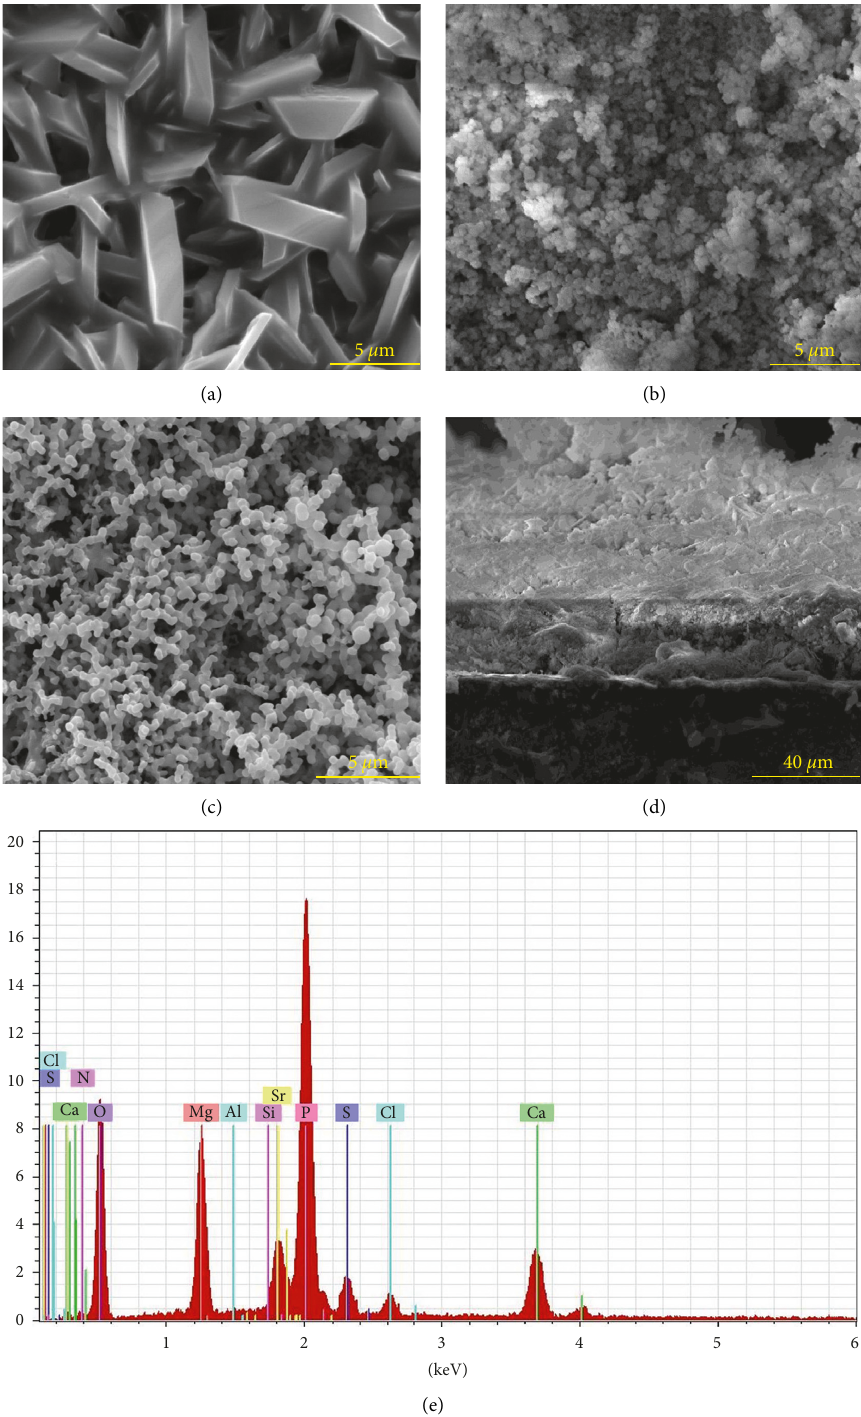
Figure 4: HRSEM micrographs of (a) PEDOT-HNTcoated on the Ti alloy, (b) CS-MHA coated on the Ti alloy, (c) PEDOT-HNT/CS-MHA bilayer composite coated on the Ti alloy, (d) cross-sectional image for PEDOT–HNT/CS-MHAP bilayer coating, and (e) EDAX spectrum of the PEDOT-HNT/CS-MHA bilayer composite coated on the Ti